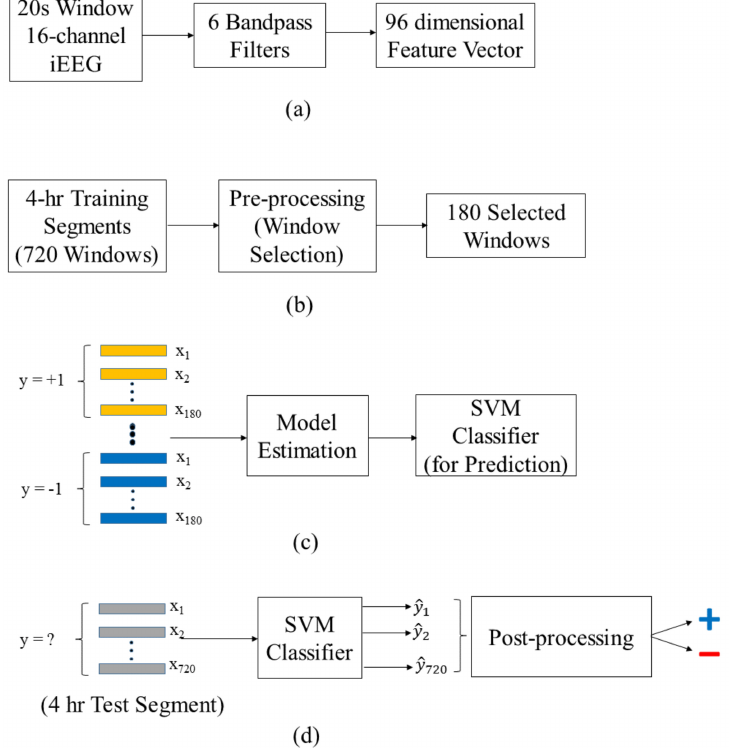
Figure 4. Overview of the proposed system: ( a ) feature encoding for 20 s windows; ( b ) preprocessing (~window selection); ( c ) model estimation (~SVM training); ( d ) test/prediction